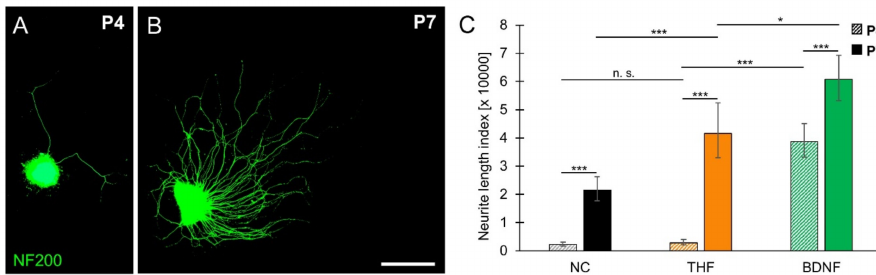
Figure 4. Age-dependent e ffi cacy of THF. SGEs from P4 and P7 mouse cochlea were cultured in medium devoid of neurotrophic compounds (NC) or in medium supplemented with 1 µ M THF or 25 ng / mL BDNF. After 4 DIV, SGEs were fixed and stained for NF200. ( A , B ) Images of THF-treated NF200-immunolabeled (green) P4 (A) and P7 (B) SGEs are shown. Scale bar (A,B): 500 µ m. ( C ) Neurite outgrowth was quantified and statistically compared for P4 (patterned bars) and P7 (solid bars) SGEs. Barsrepresentgeometricmeansin µ m; errorbarsindicate ± upperandlower95%confidenceintervalsfor the mean; one-way ANOVA, Dunnett post-hoc test (to compare di ff erent treatments) or Tukey–Kramer post-hoc test (to compare di ff erent ages); n. s. = not significant ( p > 0.05), * p < 0.05, *** p < 0.001.